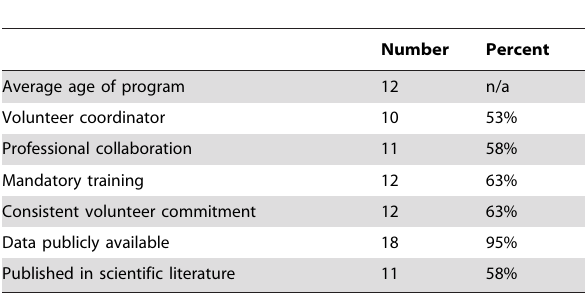
Table 1. Attributes of volunteer programs.